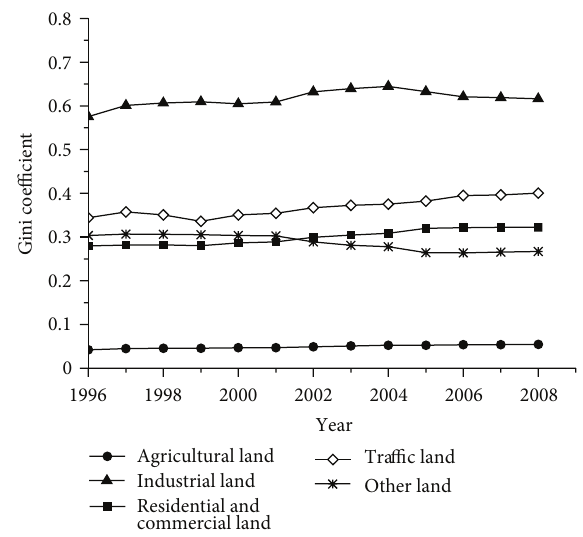
Figure 5: Changes in the Gini coefficients of different land use types from 1996 to